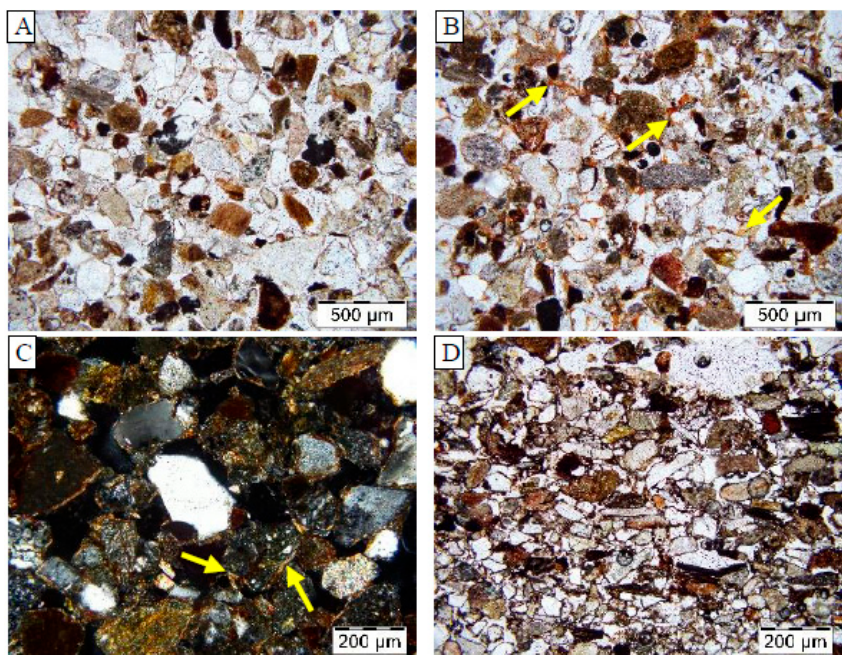
Figure 7. Pedofeatures of the C horizons in the surface soil. ( A,B ) Microphotographs of C2 horizon (110–115 cm). ( A ) the zone of coarse monic c/f-related distribution and ( B ) the zone of concave gefuric c/f-related distribution; note the red-brown colored links between the sand grains (marked by yellow arrows); NII. ( C ) Microphotograph of the C1 horizon (60–65 cm) with stagnic features, please note bleached clay coatings (marked by yellow arrows); NX. ( D ) Microphotograph of the R horizon (130–132 cm); note the enrichment in dark fine material in comparison to the microphotograph A; NII.